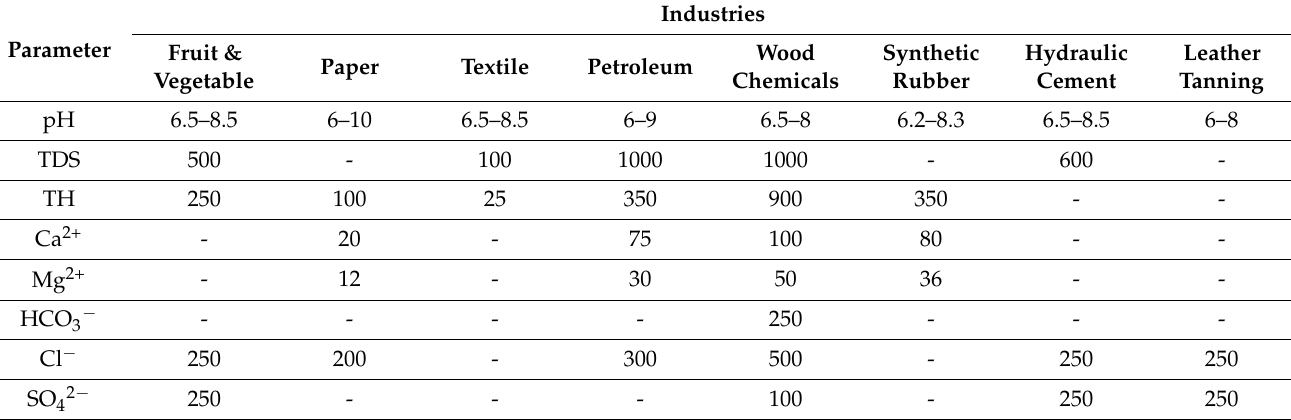
Table 3. Water quality requirements for some industries according to